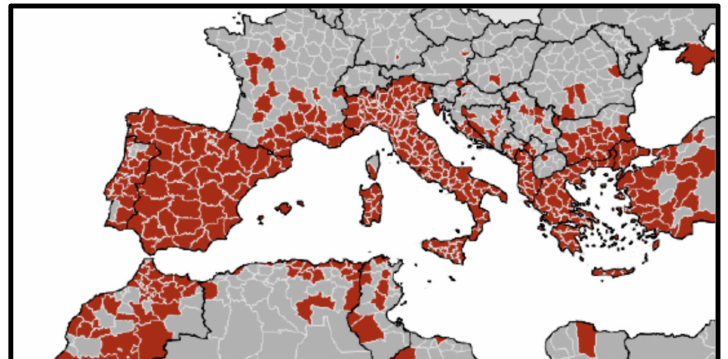
Figure 2. Geographical distribution of reported human and/or animal cases of leishmaniosis due to L. infantum between 2009 to 2020 (data obtained by Technical Report of European Centre for Disease Prevention and Control (ECDPC)